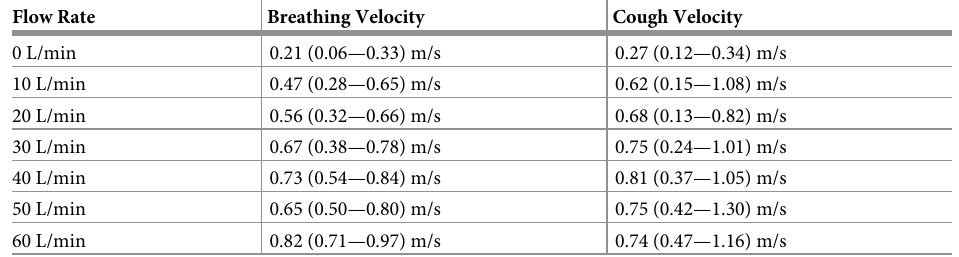
Table 2. Summary of schlieren imaging data analysis